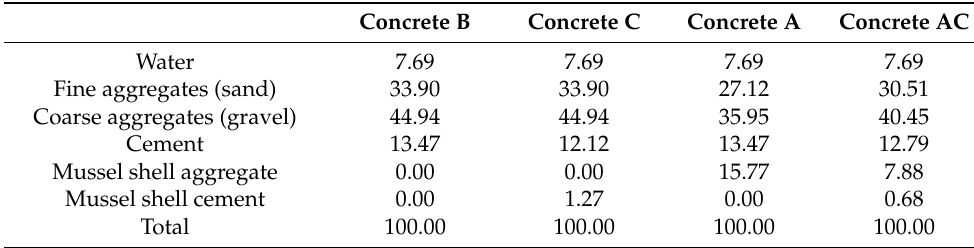
Table 1. Concrete compositions (wt.%).